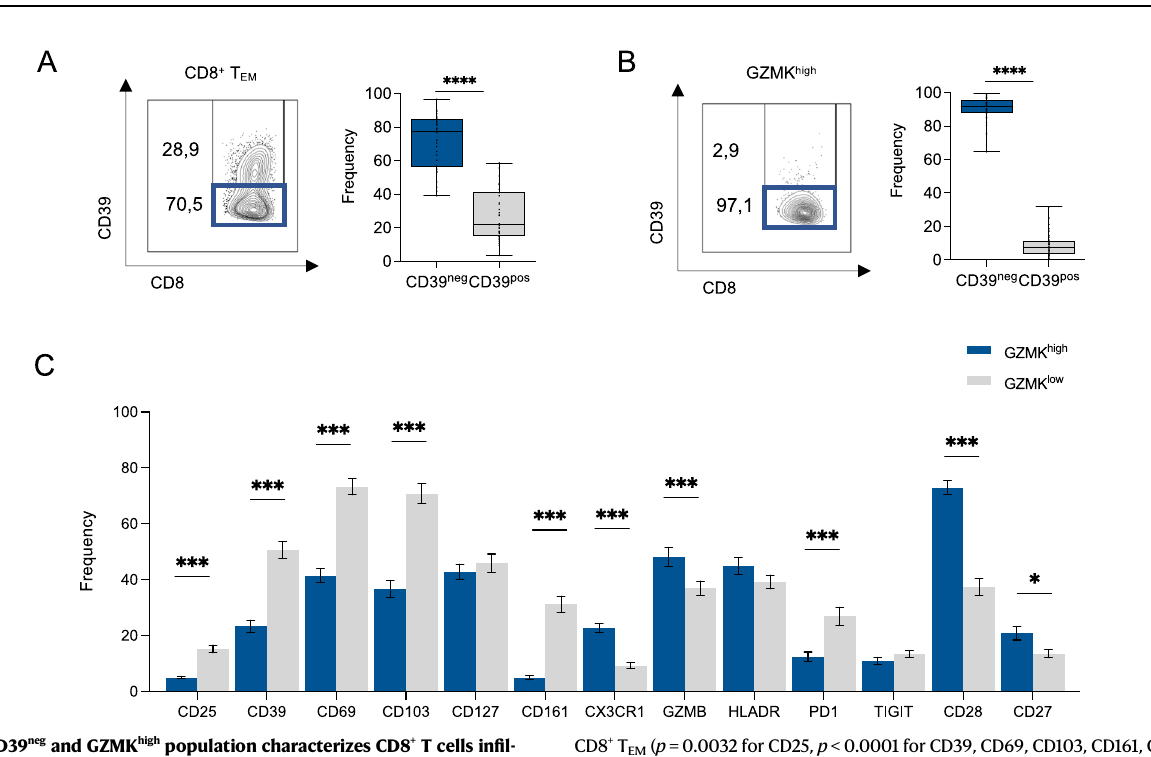
Fig. 2 | High-dimensional single cell analysis of CD8 + T cells identi fi es a tumor- identi fi ed18clustersofconcatenatedCD8 + TcellsfromT( n =34),NAT( n =17),and speci fi c CD39 neg GZMK high population enriched in CRC. A CD3 Lymphocytes PB( n =22)fromCRCpatients. F Clusterrepresentationindifferenttissues:PB,NAT, T. G Hierarchical metaclustering of CRC patient ’ s samples based on Phenograph frequency within CD45 + in tumor (T) compared with normal adjacent tissue (NAT) identi fi ed clusters using Ward ’ s minimum variance method. For each sample, ( n =29, p <0.0001). B – D UMAPrepresentationofconcatenatedCD3 + TcellsfromT sampletype,grade,sex,andageareindicated( n =71). H Balloonplotoftheaverage samples with bar plot quanti fi cation. B Cytotoxic CD8 + T cells (blue), Th CD4 + (purple), Treg CD4 + , CD25 + , CD127 − (pink), and γδ T cells (orange) distribution expression levels and expression frequencies of marker of differentiation, resi- ( n =29, p <0.0001). C Naive T cells (T NAIVE , light green), central memory T cells dency, memory, cytotoxicity, tumor reactivity, activation, and exhaustion in clus- (T CM , dark green), effector memory T cells (T EM , dark blue), effector memory cells ters identi fi ed in ( E , F ) and enriched in T ( n =34). I Frequency of CD39 pos /GZMK low re-expressingCD45RA(T EMRA ,lightblue)distribution( n =31)( p <0.0001forT NAIVE andCD39 pos /GZMK high withinCluster4andCluster12( n =34)( p value<0.001).Bars vs T CM , T NAIVE vs T EM , T CM vs T E M, T EM vs T EMRA ; p =0.0031 for T NAIVE vs T EMRA ; represent mean±SEM or box and whisker plots indicate Min to Max value, two- n =31) p =0.9651 for T tailedpairedWilcoxontest( A ),two-tailedone-wayAnova( B – F ),two-tailedpairedt CM vs T EMRA ). D Effector memory T cells subtypes (EM 1 – 4 ) ( ( p <0.0001forEM 1 vsEM 3 ,EM 1 vsEM 4 ,EM 2 vs EM 3 ,EM 2 vsEM 4 ; p =0.0071forEM 1 test ( I ). Source data are provided as a Source Data fi le. vsEM 2 ; p =0.6521forEM 3 vsEM 4 ). E tSNErepresentationof Phenographalgorithm